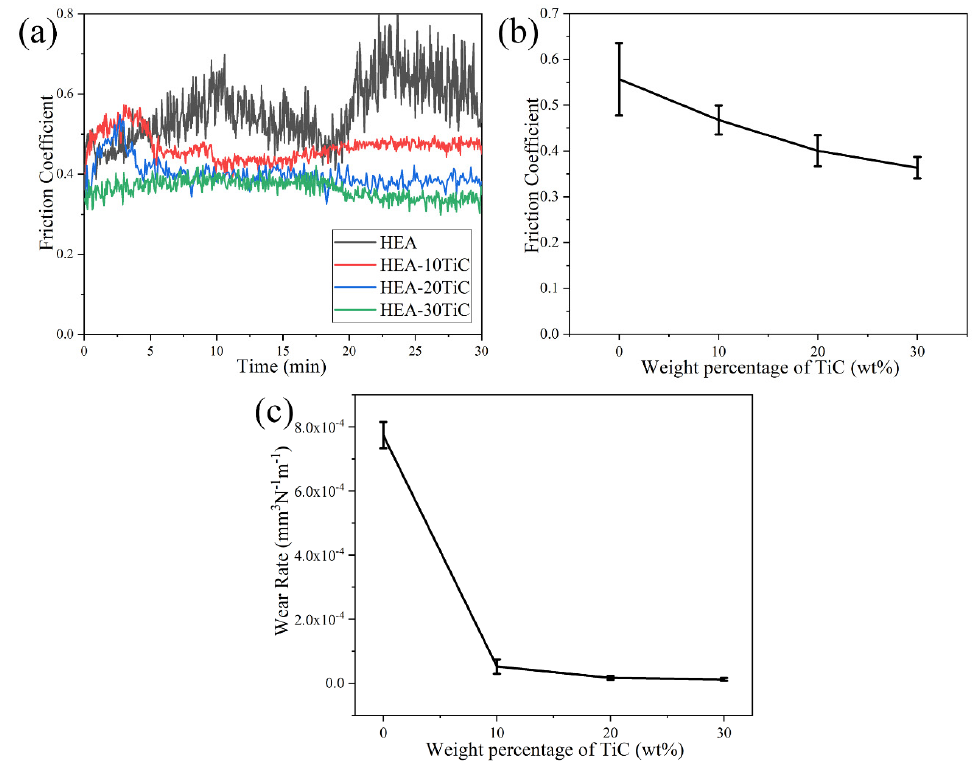
Figure 9. ( a ) Friction coefficient vs. sliding time. ( b ) Friction coefficient vs. TiC content ( c ). Wear rate of HEA-TiC composites at high temperature.